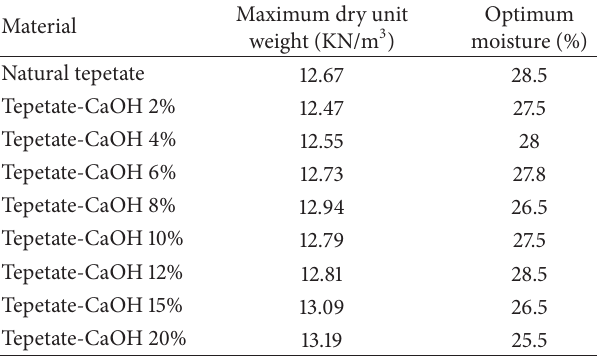
Figure 1: Strength time variation of the sustainable-tepetate com-